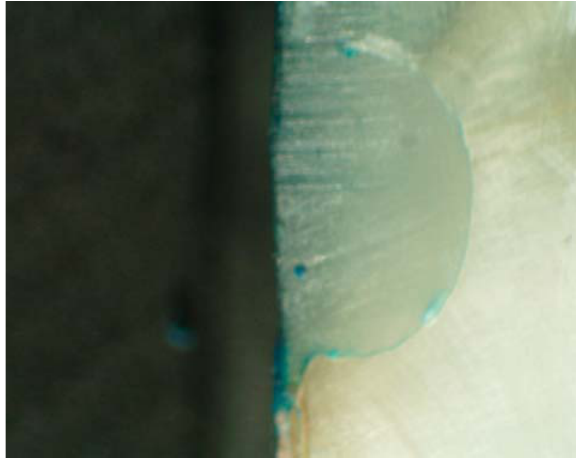
Figure 5- Photomicrograph of gamma group (bur) showing micro leakage (score 3)